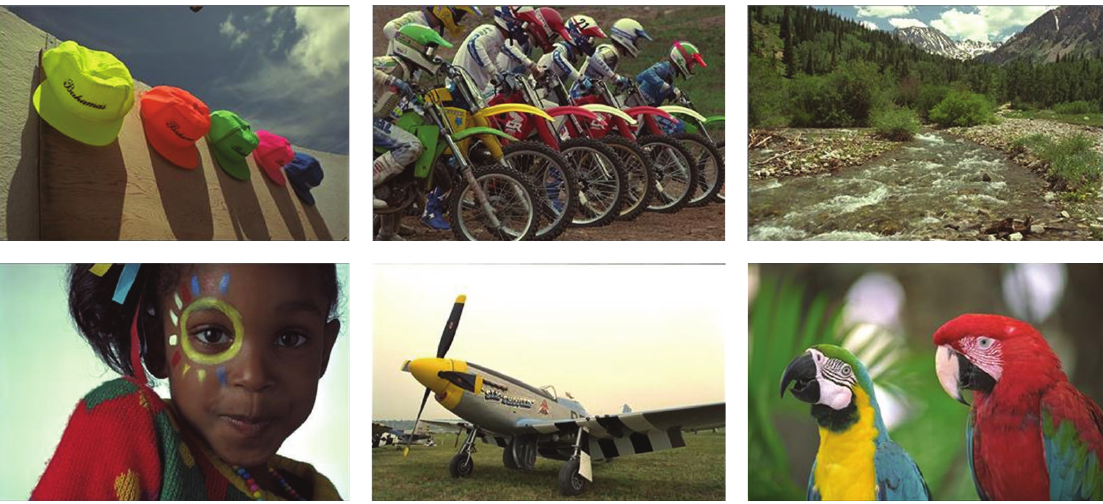
Figure 8: Some examples of the test images in Kodak losses true color image suite